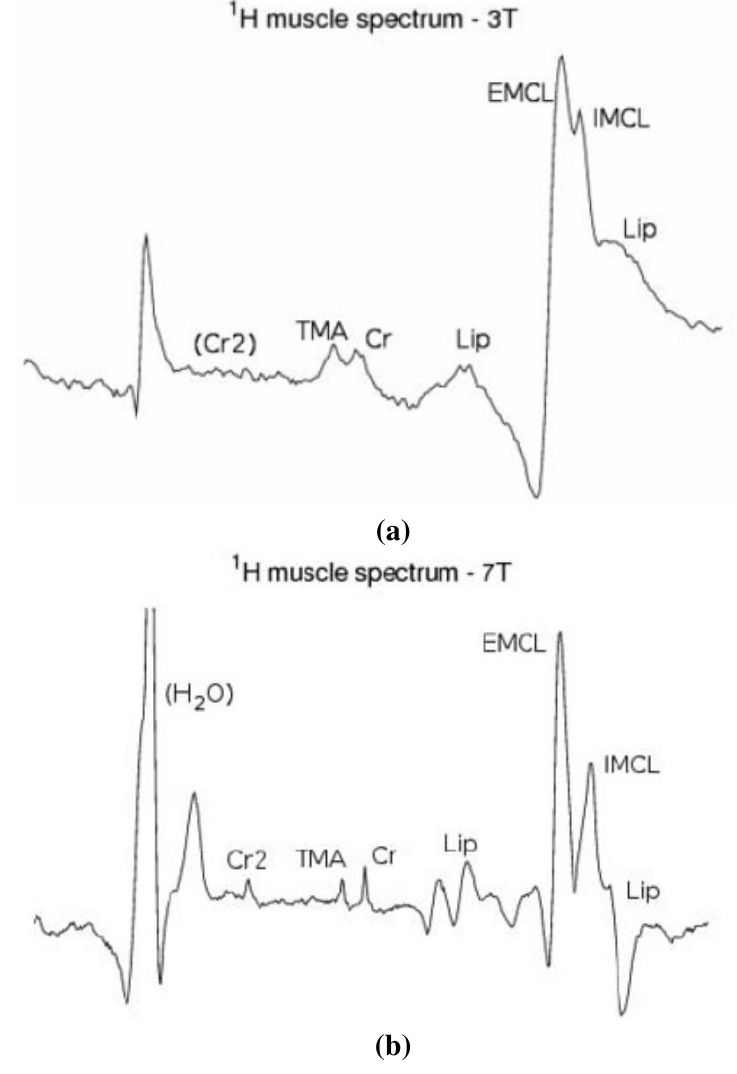
Figure 10. 1 H spectra of skeletal muscle acquired at 3 T (a) and 7 T (b), demonstrating improvement of spectral quality with increasing B field strength are improved separation of resonances and higher signal to noise ratio